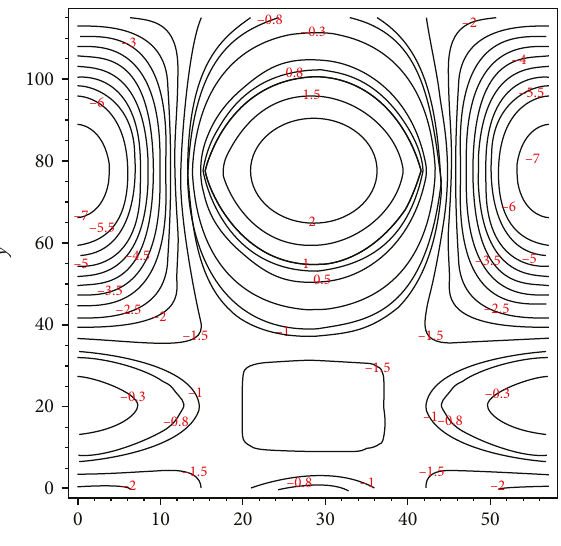
Figure 8: Distribution of maximum principal stress.